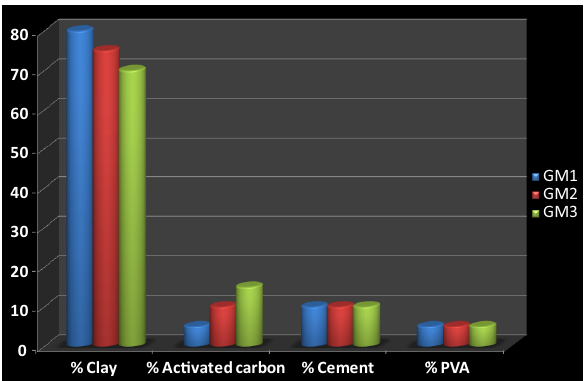
Figure 1: Composition of